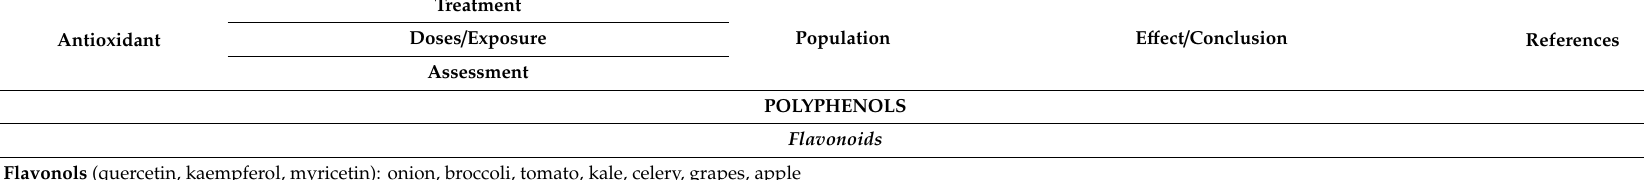
Table 1. Dietary antioxidants intake and supplementation in prevention and adjuvant treatment in patients with neurodegenerative disease